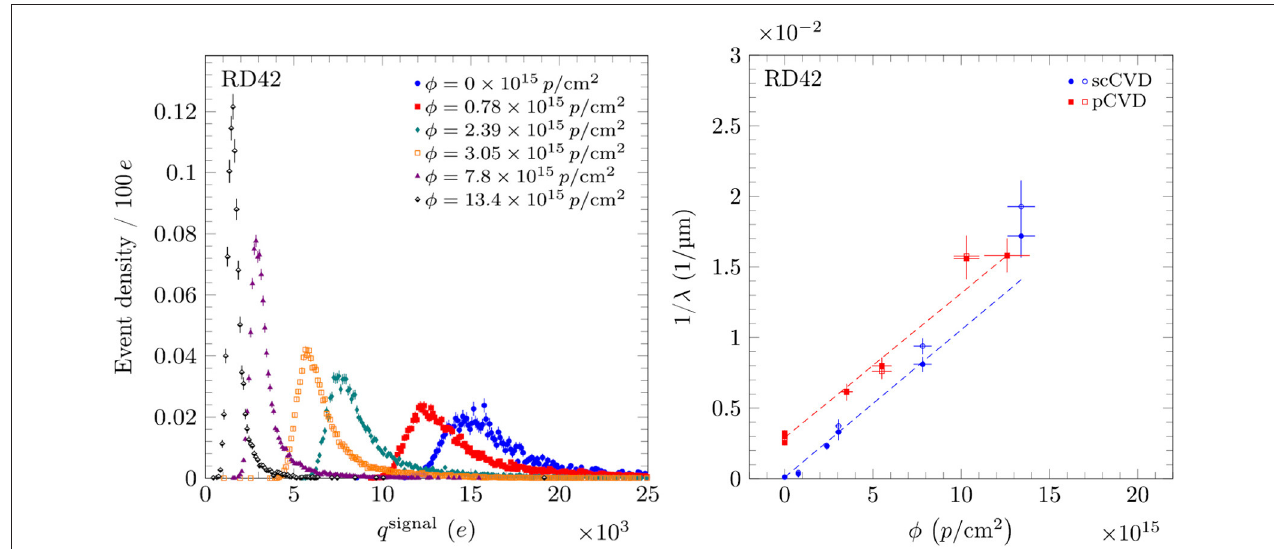
FIGURE 1 | On the left pulse height evolution for a scCVD diamonds irradiated with 800 MeV protons (E= with 800 MeV protons. The two values for each fluence represent positive and negative biasing with E= Commons CC BY license.